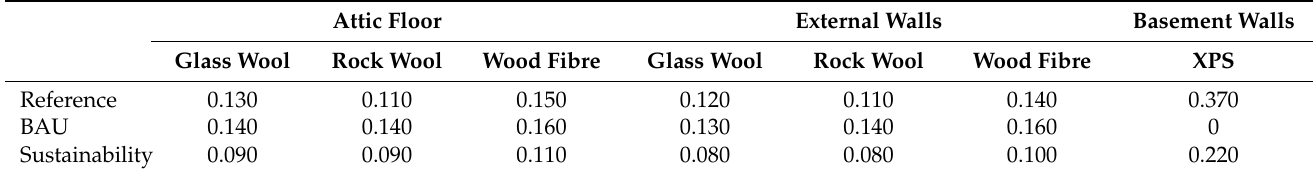
Figure 6. Marginal energy cost savings and marginal retrofit costs of new thermally-efficient windows using aluminum and wood frames.